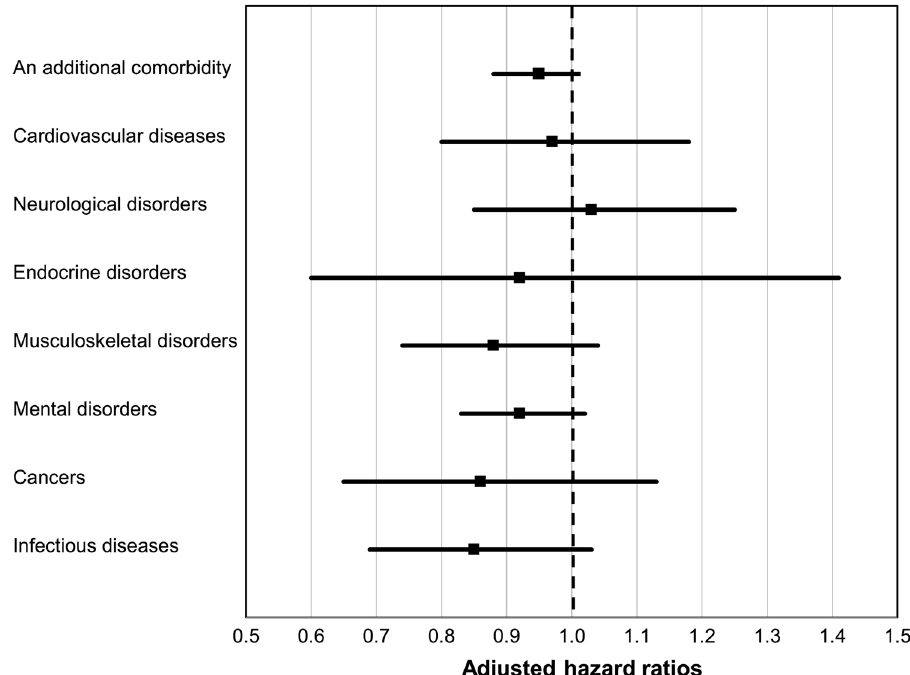
Fig. 2 Associations of physical activity with incident comorbidities. The relative-risk ratios estimated from multinomial logistic regression models (competing risk model) were interpreted as hazard ratios. Age, sex, body mass index, smoking pack-years, and forced expiratory volume in 1 s (liters) were included as covariates in the